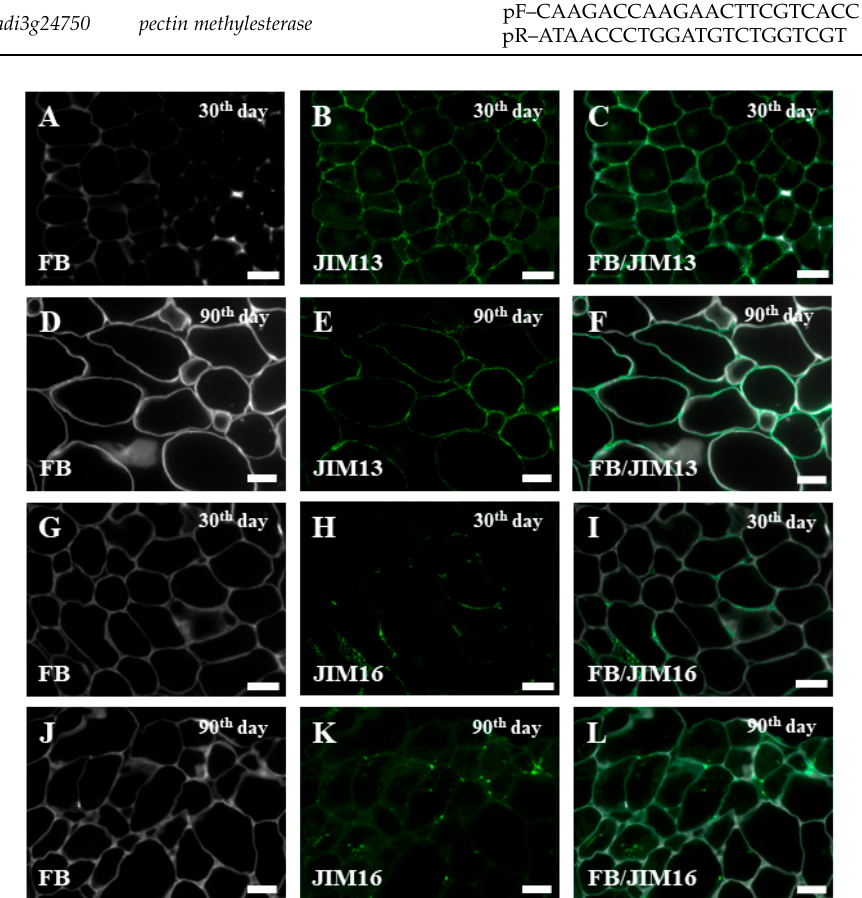
Figure A1. Immunolocalisation of JIM13 ( A – F ) and JIM16 ( G – L ) in B. distachyon callus. ( A – C , G – I ) 30th day of cultivation; ( D – F , J – L ) 90th day of cultivation. FB: fluorescent brightener. Scale bars, 10 μ m.